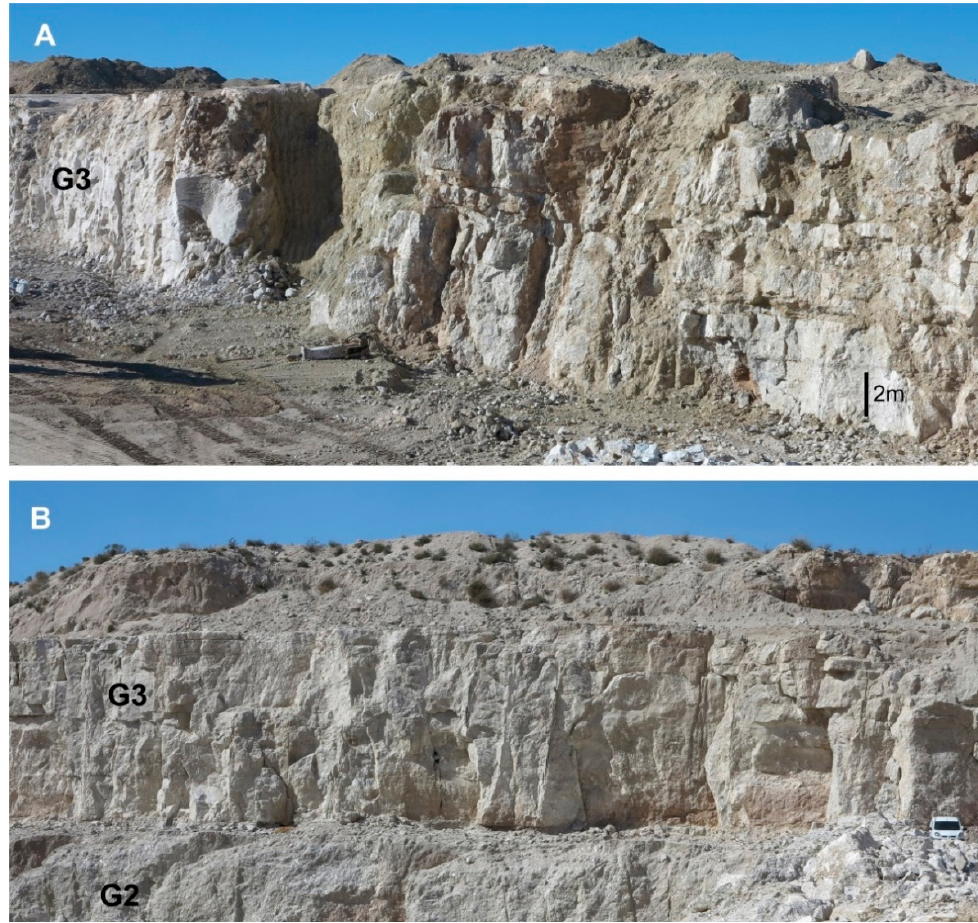
Figure 16. Quarry fronts: ( A ) view of the quarry, showing a large fracture zone with relatively abundant shaley material, within gypsum bank G3, which could be the similar context in which there is a decrease in resistivity in the subsurface, such as those observed in the ERT profiles performed. ( B ) Quarry front where there is a continuity of gypsum